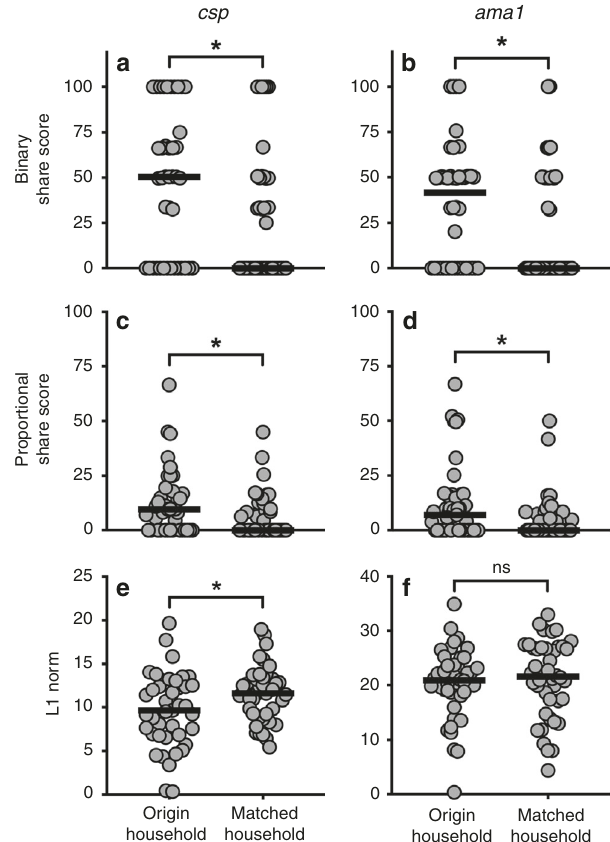
Fig. 4 Enhanced parasite genetic similarity between case children and their own household members. Genetic similarity metrics (binary share score, proportional share score, and L1 norm) were computed for case children (CC) with both their household of origin as well as with an unrelated household matched on time. Each metric was computed independently for csp and for ama1 . a , b CC had signi fi cantly higher csp ( a ) and ama1 ( b ) binary share scores with infected members of their origin households compared to members of matched households. c , d Furthermore, a higher proportional share score was observed for CC with their household of origin at both csp ( c ) and ama1 ( d ) loci. e , f A reduced L1 norm for origin household (i.e. greater sequence similarity) was observed for csp ( e ) though not ama1 ( f ) haplotypes. * p <0.05, Wilcoxon Signed-Rank